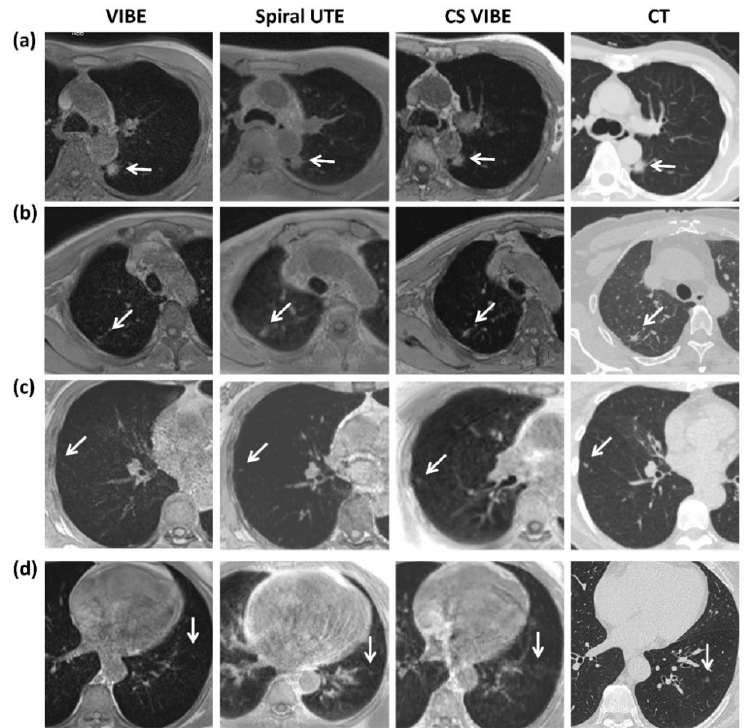
Figure 4. ( a ) Example of a 63-year-old man with an 18 mm part-solid nodule (white arrow) in the left lower lung shown on a reference axial CT image, detected clearly on conventional breath-hold VIBE, free-breathing spiral UTE MR, and breath-hold CS-VIBE images. ( b ) Example of a 66-year-old man with a 6 mm solid nodule (white arrow) in the right upper lung shown on a reference axial CT image, blurred on conventional breath-hold VIBE, and clearly depicted on free-breathing spiral UTE MR and breath-hold CS-VIBE images. ( c ) Example of a 55-year-old woman with a 4 mm solid nodule (white arrow) in the right lower lung shown on a reference axial CT image, detected vaguely on conventional breath-hold VIBE, and clearly depicted on free-breathing spiral UTE MR and breath- hold CS-VIBE images. ( d ) Example of a 60-year-old woman with a 4 mm non-solid nodule (white arrow) in the left lower lung shown on a reference axial CT image, detected on free-breathing spiral UTE, which could be easily missed on conventional breath-hold VIBE or CS-VIBE images due to cardiac pulsation artifacts. Abbreviations: MR: magnetic resonance; VIBE: volumetric interpolated breath-hold examination; UTE: ultrashort echo time; CS: compressed